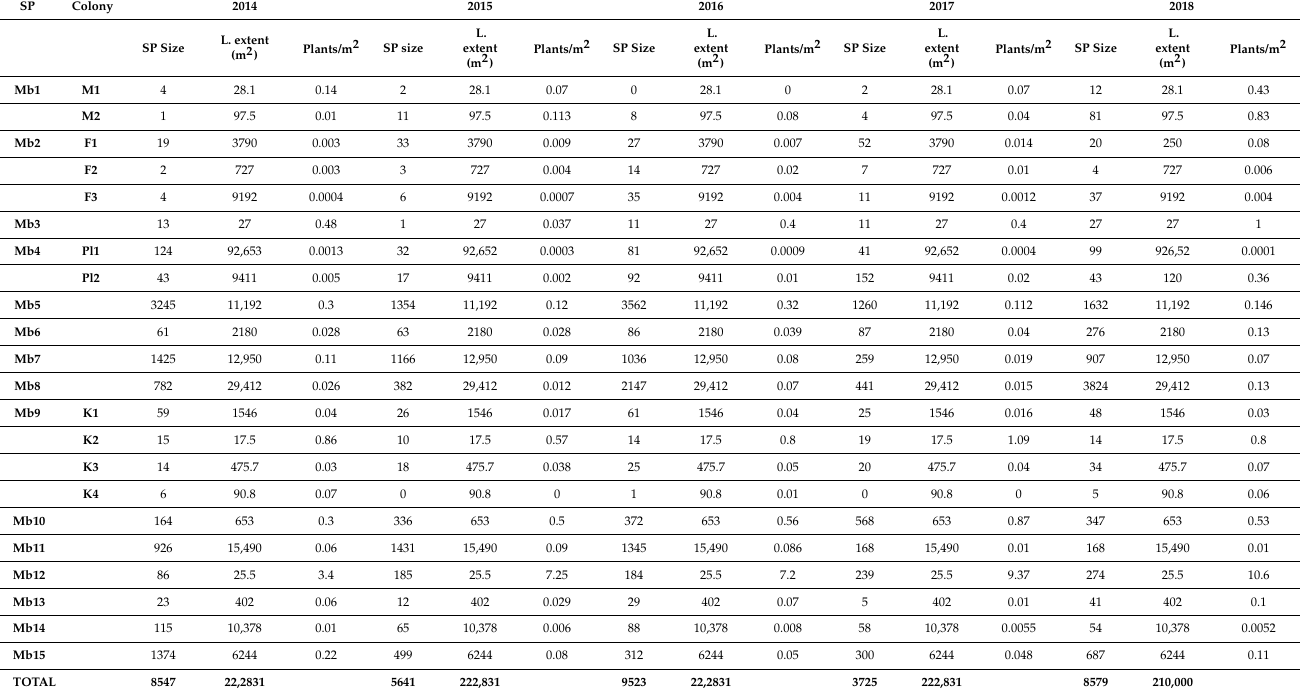
Table 2. Number of mature individuals (subpopulation size), local extent (the minimum area polygon or polygons including all the plant colonies not separated by unsuitable habitat at each location) and plants per m 2 for each subpopulation per year. Subpopulation abbreviations as in Table 1. SP: subpopulation.